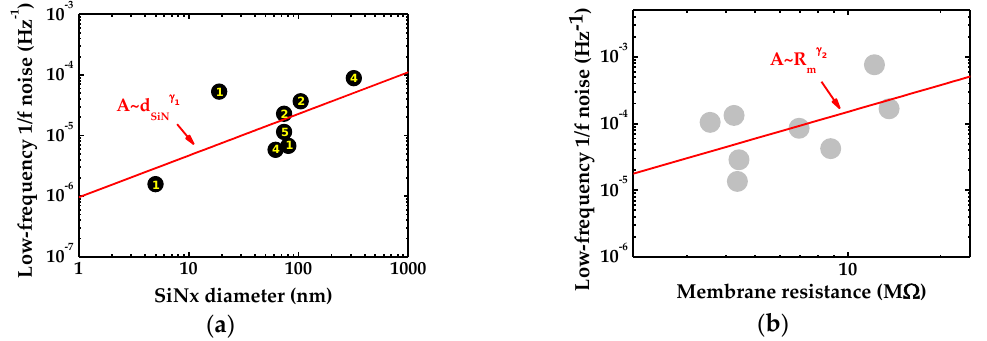
Figure 4. ( a ) Low-frequency noise power plotted against the underlying SiN x diameter. The yellow number in the center of the points represent the pore size of each graphene nanopore; and ( b ) the noise in the low-frequency range versus membrane resistance. The red solid line fits to the resistance of eight graphene nanopores.